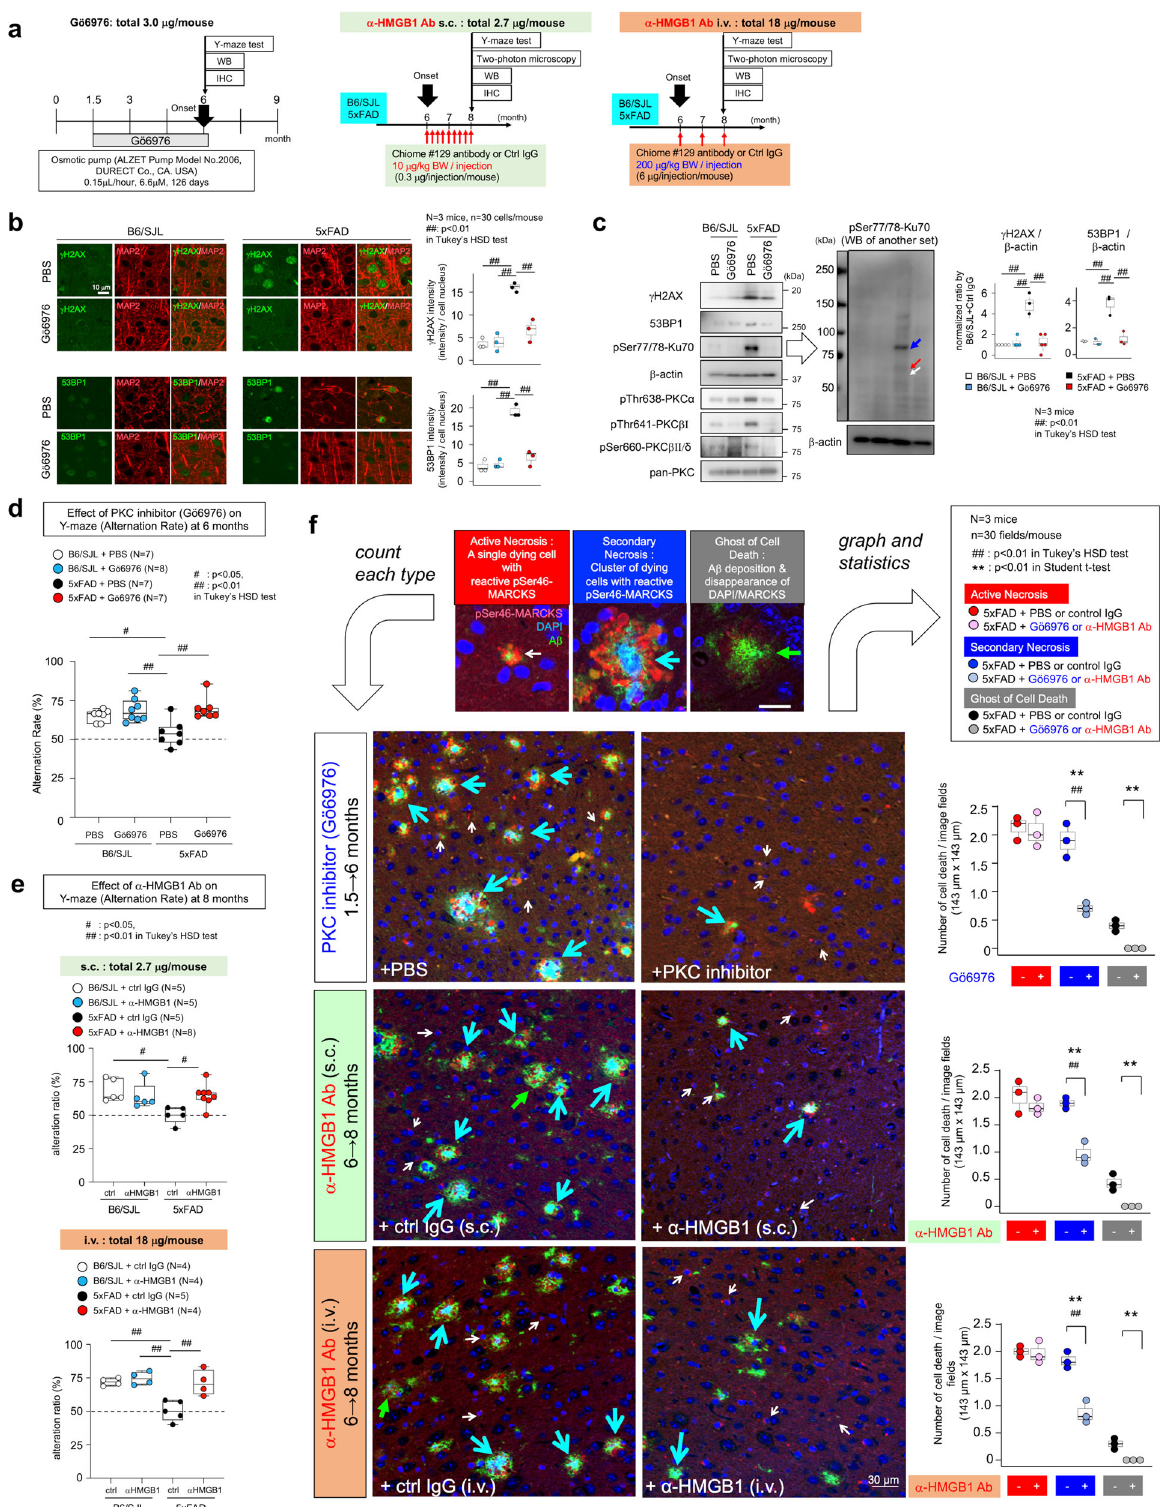
Y-maze tests of 5xFAD mice (Fig. 6d). Interruption of the upstream signal of PKC α activation by antibody #129 similarly recovered cognitive impairment in 5xFAD (Fig.